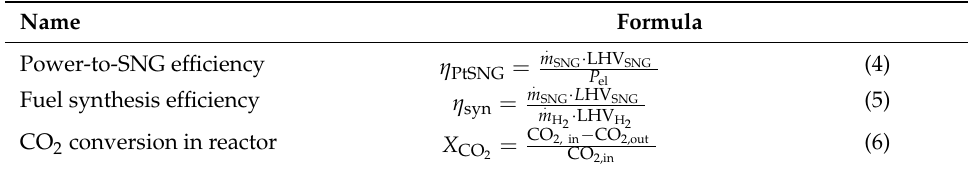
Table 3. Definition of process performance